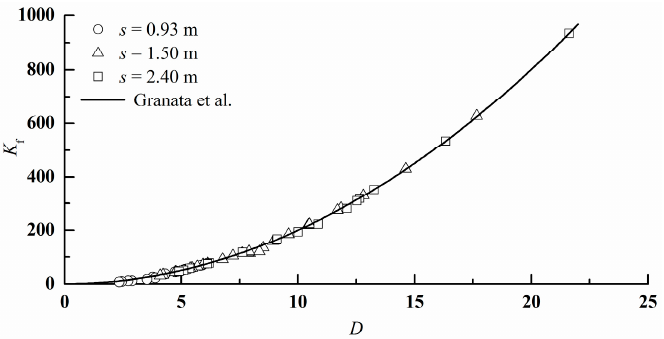
Figure 6. K f versus D for entire present test range.